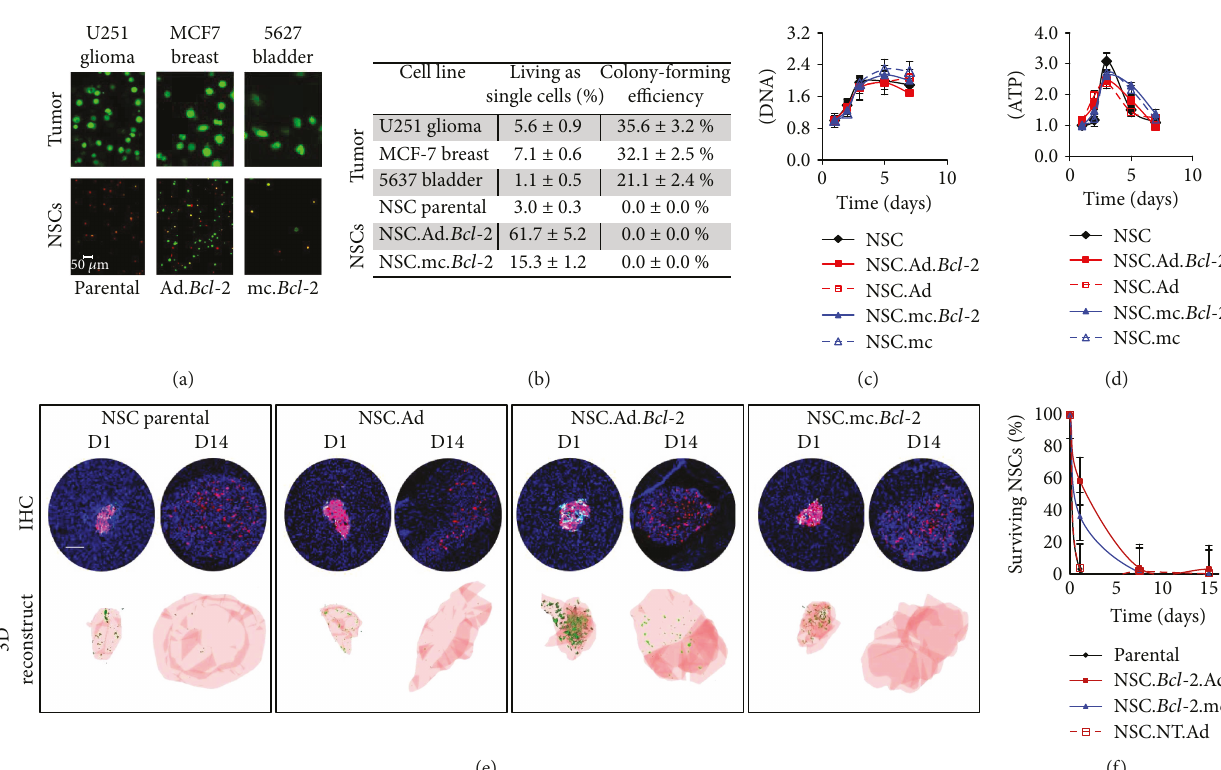
Figure 5: Tumorigenicity of Bcl-2 modi fi ed HB1.F3.CD NSCs. (a-b) Bcl-2 -expressing NSCs showed no tendency to form tumorigenic colonies characteristic of cancer cells when cultured for 7 days in agar. (a) Representative 20x confocal microscopy z-stacks obtained on day 7 after calcein-AM labeling. Tumor colonies are visible in the top panel (ordered right to left: U251 glioma, MCF7 breast cancer, and 5637 bladder cancer) and NSCs are visible in the bottom panel (ordered right to left: parental, Ad. Bcl-2 , and mc. Bcl-2 ). Scale bar in lower left image=50 μ m which applies to all images in Figure 5(a). (b) Table displaying quantitative data obtained using ImageJ analysis software to count and size colonies in 5 images per condition. Values are normalized with respect to initial day 0 seeding counts. Colonies were de fi ned as clusters with diameters > 20 μ m. (c-d) Total DNA (c) and ATP (d) levels measured as NSCs proliferated in monolayer culture over the course of 1 week. (e-f) Decline of eGFP positive NSCs over the course of two weeks after implantation into tumor- and nontumor-bearing brains. (e) Representative brain sections and 3D renderings of tumors reconstructed from serially sectioned brains highlighting the distribution of eGFP-expressing NSCs within a DsRed-expressing glioma. Scale bar =100 μ m. (f) Quanti fi ed estimate of the percent of injected eGFP-expressing NSCs present within tumors over the course of 2